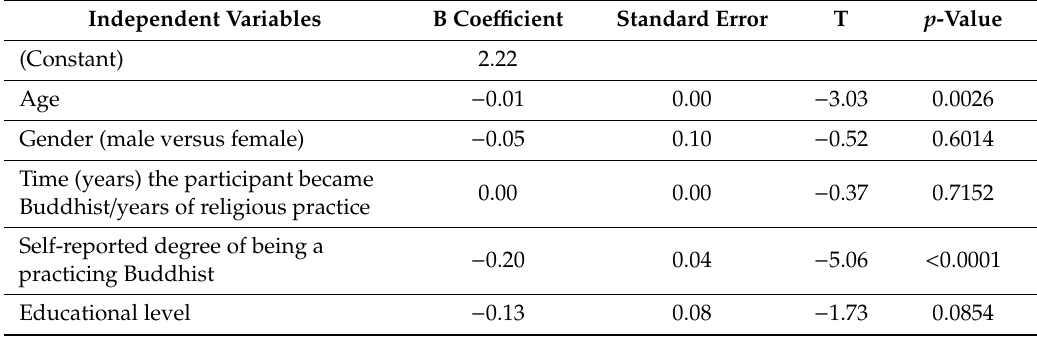
Table 6. Multiple regression analysis assessing determinants of external and internal locus of control in Italian